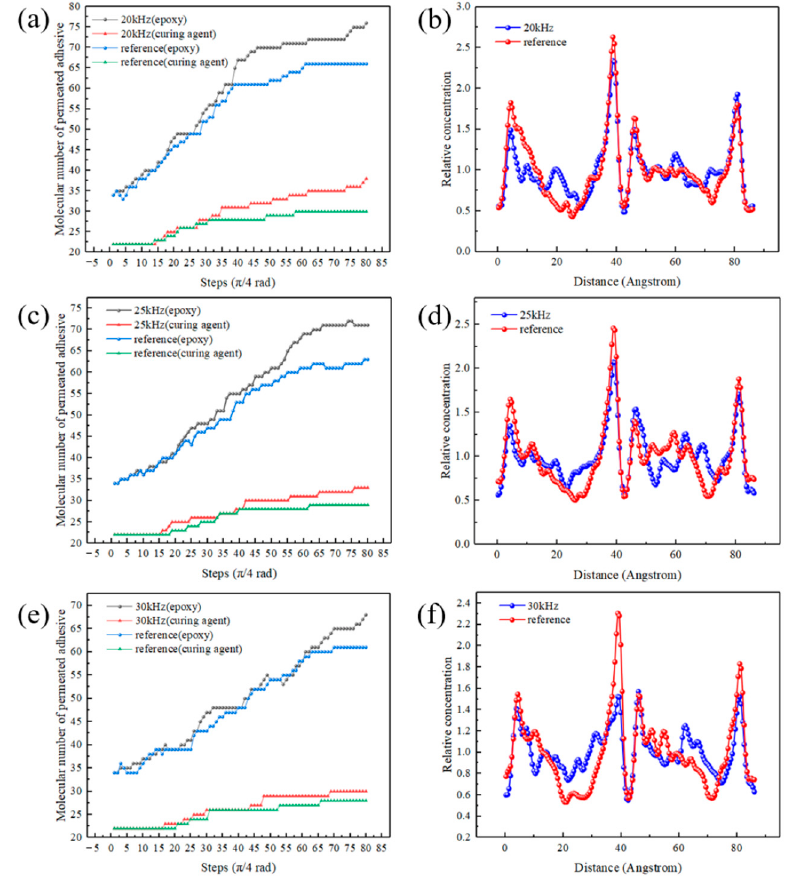
Figure 13. Molecular numbers of permeated adhesive under the ultrasonic action of ( a ) 20 kHz, ( c ) 25 kHz and ( e ) 30 kHz and concentration profiles of the final states of ( b ) 20 kHz, ( d ) 25 kHz and ( f ) 30 kHz.